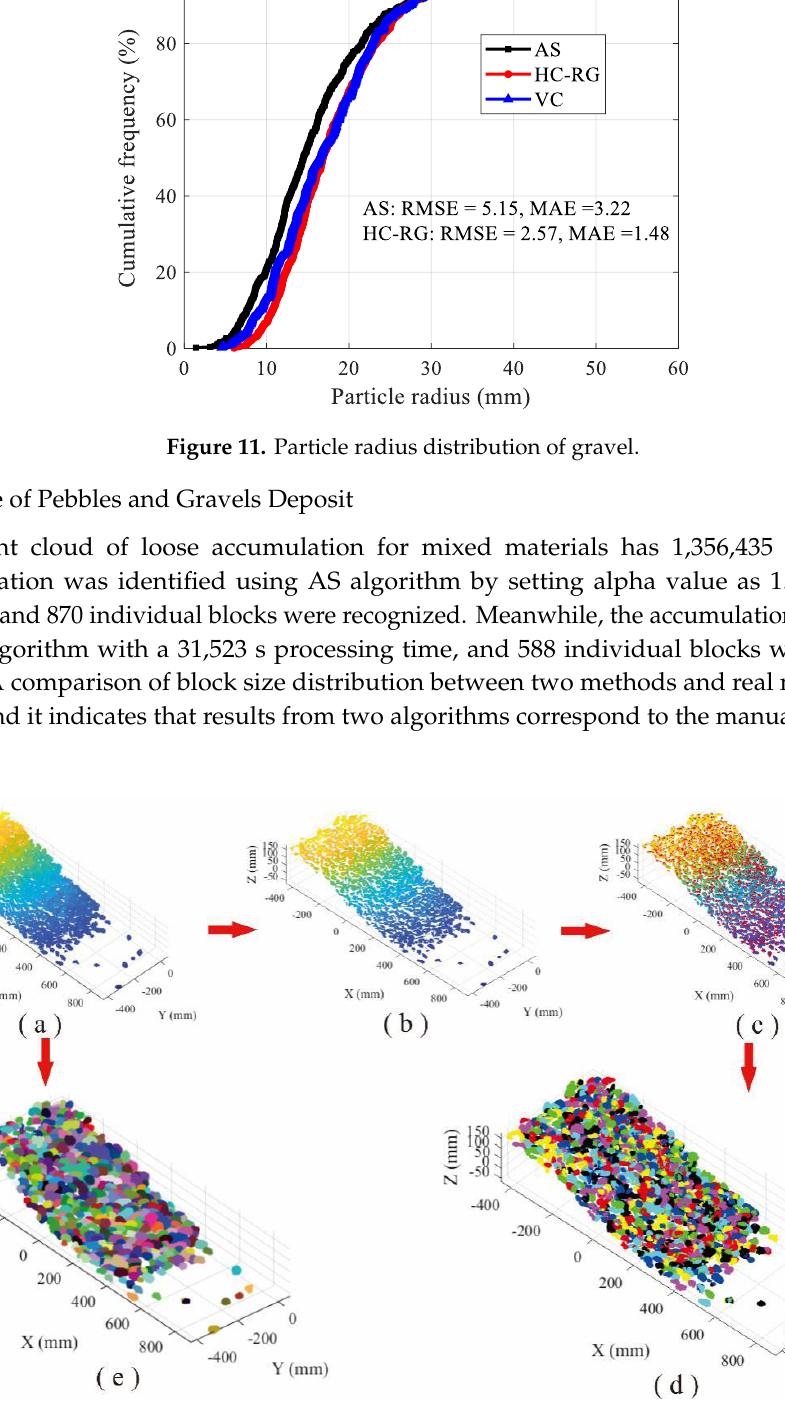
9 of 16 Figure 10. Comparison of recognition performance of gravel loose accumulation: ( a ) point cloud, ( b ) separation processing, ( c ) peak points of each block region, ( d ) recognition using HC-RG algorithm,